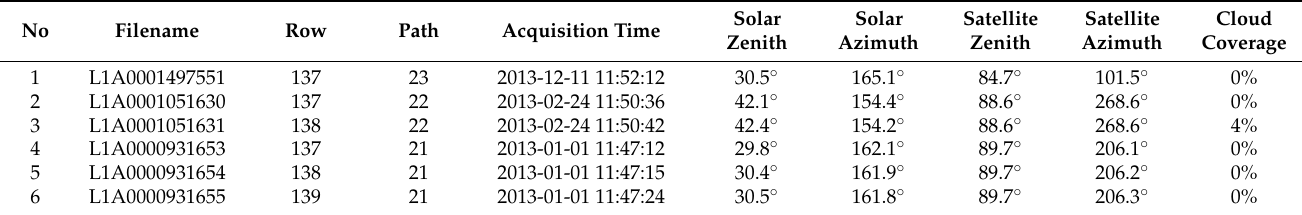
Table 2. Metadata of the ZY3 stereo images of the Qianhe